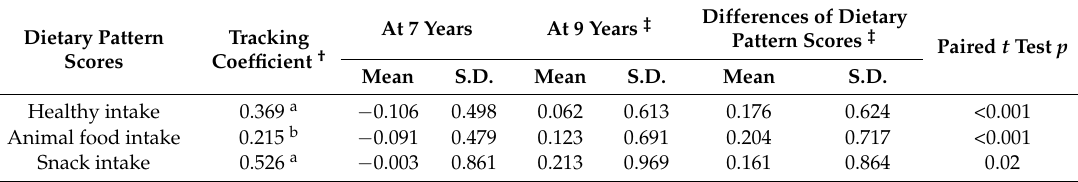
Table 3. Changes in dietary pattern scores between the two observational times.